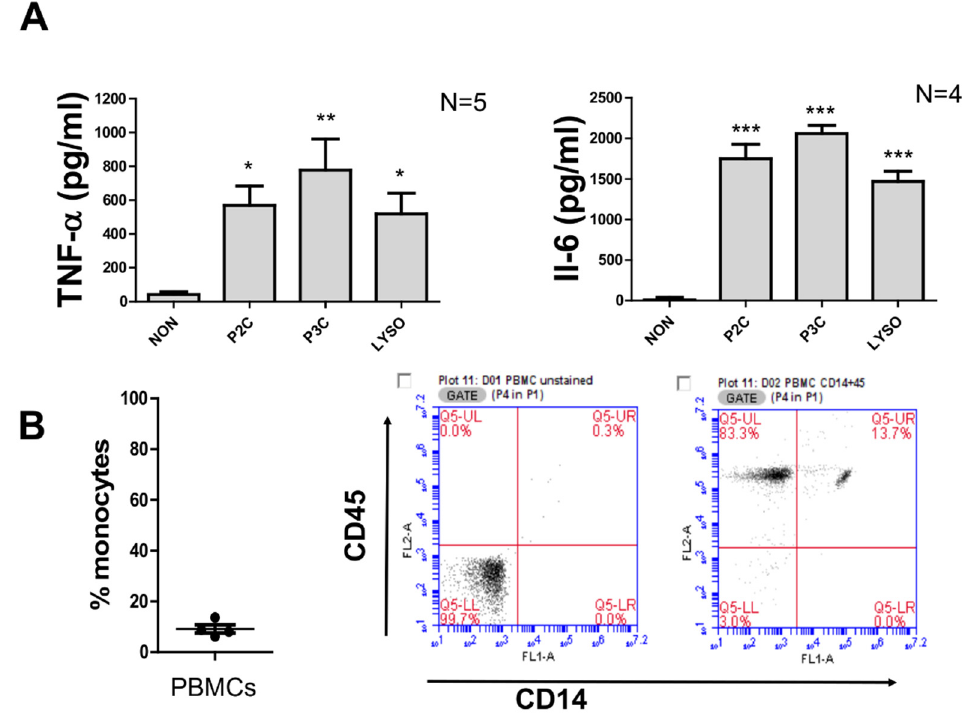
Figure 1. Cytokine production of PBMCs induced by lipopeptides. ( A ). Cytokine production of PBMCs with 100 ng/mL of P2C, P3C, or Lyso. The control samples (non) were used without adding any stimulators. TNF values were measured by ELISA from supernatant of 5 h stimulation, and IL6 and IL-10 were measured by ELISA from supernatant of 18 h stimulation. Samples from 5 donors were analysed in triplicate. Error bars represent the SEM. Statistical significances were calculated between the treated cells compared to control (non) by using Kuskal–Wallis test * p < 0.05, ** p < 0.01, *** p < 0.001. ( B ). Percentage of monocytes in isolated PBMCs. Cells were stained with CD14-FITC and CD45-PE antibodies. Data were obtained by flow cytometry from 4 donors. Flow cytometric analysis from a representative experiment with PBMCs unstained ( left ) and stained ( right ) with CD14-FITC and CD45-PE antibodies.